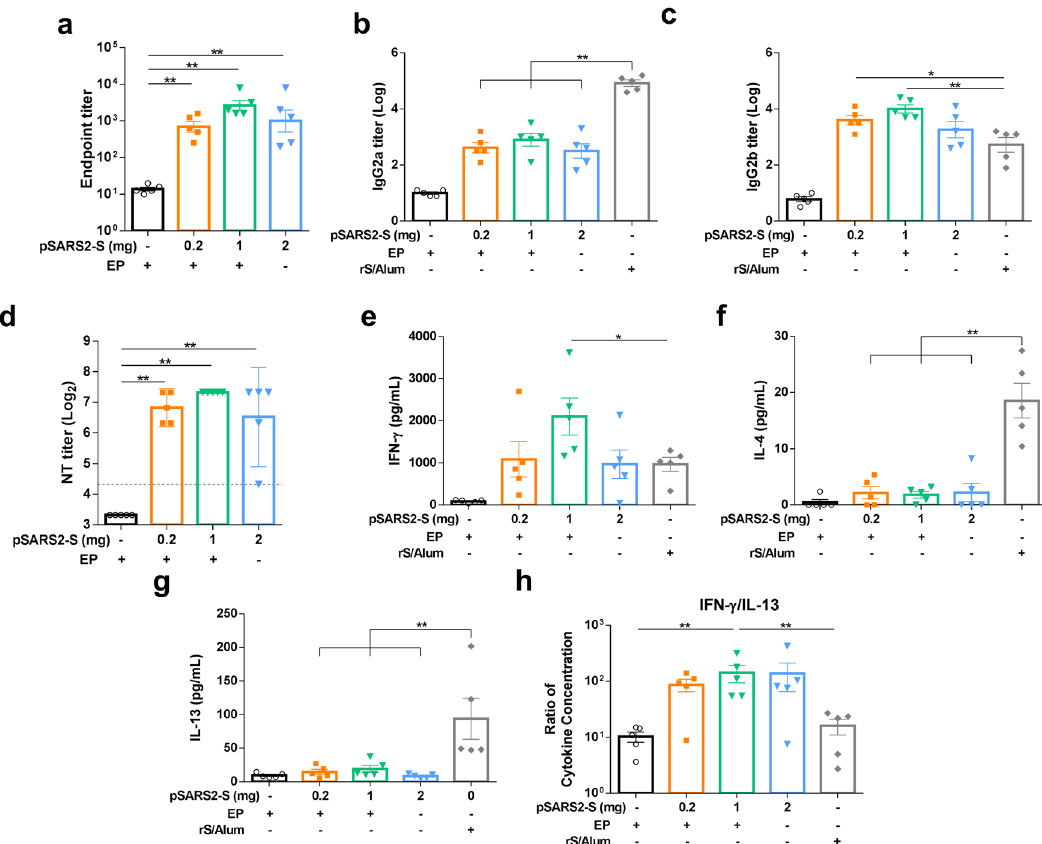
Fig. 6 Humoral and cellular responses to the pSARS2-S DNA vaccine in a repeated-dose toxicity study. Female SD rats ( n = 5 per group) were intramuscularly immunized three times at a 2-week interval with placebo, 0.2 and 1 mg of pSARS2-S DNA with electrostimulation (40 Vpp and 120 Hz for 5 s), 2 mg of pSARS2-S DNA without electrostimulation, or 20 μ g of recombinant spike protein adjuvanted with 250 μ g aluminum hydroxide (rS/Alum). Serum samples were collected at week 6 after the fi rst immunization. a IgG antibodies against spike protein were measured by ELISA. b , c Immunoglobulin G subclasses (IgG2a and IgG2b) in rat serum were detected by ELISA. d Neutralizing activity against wild-type SARS-CoV-2 was evaluated by neutralization assay. The dashed line indicates the initial fold dilution of serum samples. e – g Splenocytes were collected at week 6 after the fi rst immunization, and the levels of secreted IFN- γ , IL-4 and IL-13 were evaluated after restimulation with recombinant spike protein. h The ratio of IFN- γ to IL-13 was calculated. Neutralization titers are expressed as the geometric mean with a 95% con fi dence interval, and other data are presented as the mean ± SEM. * p < 0.05, ** p < 0.01 by the Mann – Whitney